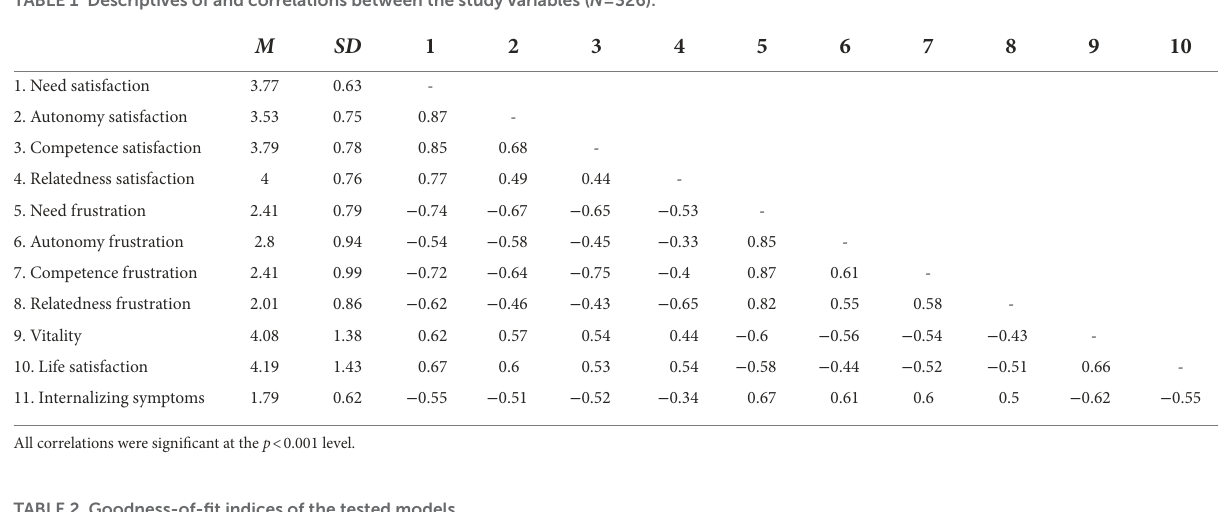
TABLE 2 Goodness-of-fit indices of the tested